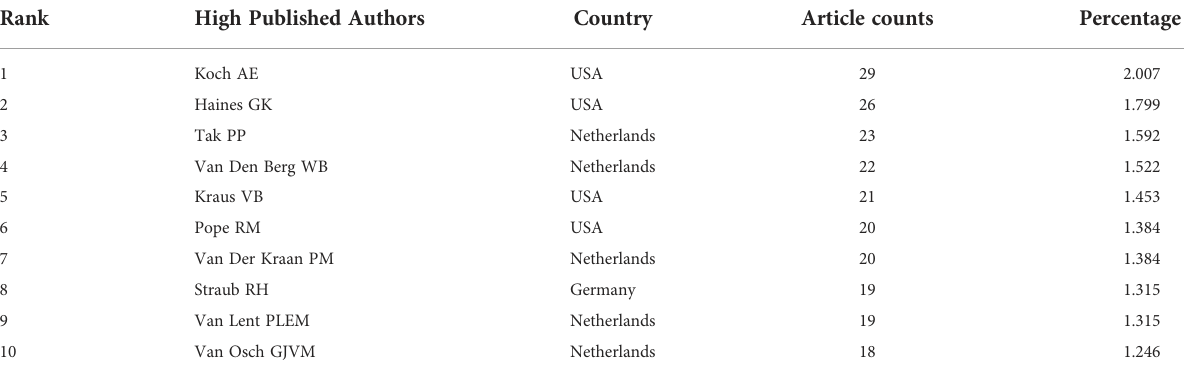
TABLE 1 The top 10 authors with the most publications on macrophages associated with osteoarthritis. Rank